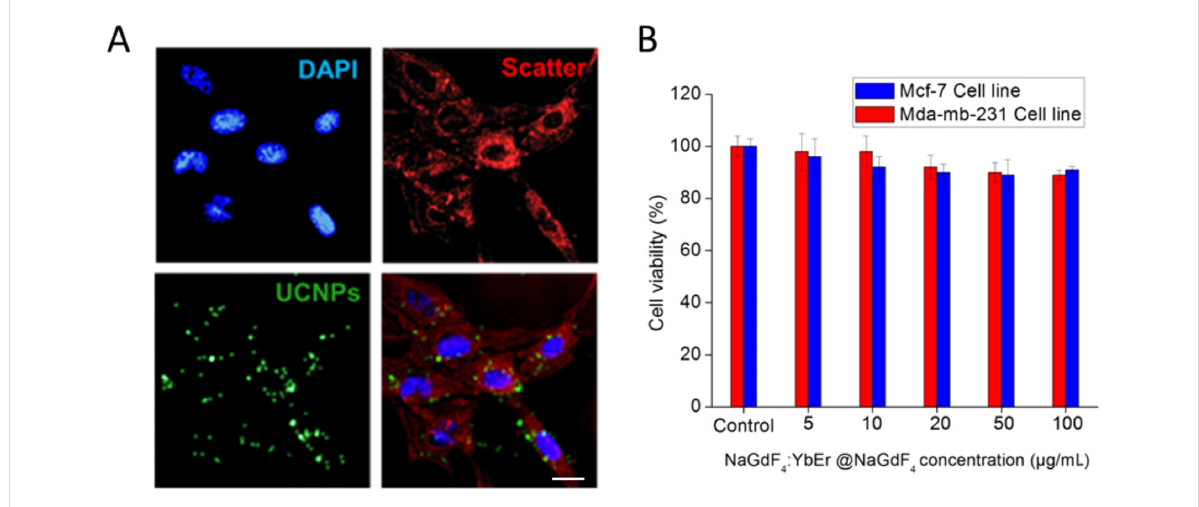
Figure 6: A) Confocal images of MDA-MB-231 cells after 24 h treatment with Tween 80-coated core–shell UCNPs (10 µg/mL); UCNPs are green, DAPI staining is blue, the red color represents excitation scattering from intracellular structures. Scale bar equals 10 µm. B) Viability of MCF-7 and MDA-MB-213 cells, treated with different concentrations of UCNPs for 24 h. Toxicity of UCNPs was investigated using XTT cell viability